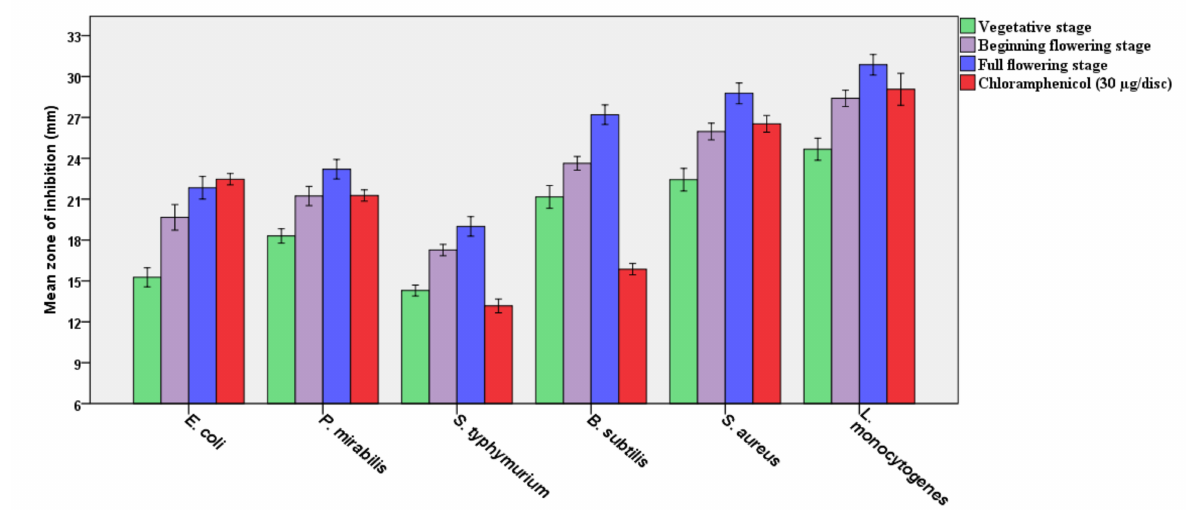
Figure 4. Mean zone of inhibitions of the three developmental stages compared to chloramphenicol. Table 2. MIC and MBC of Salvia officinalis essential oils as percentages ( v / v ) at three developmental